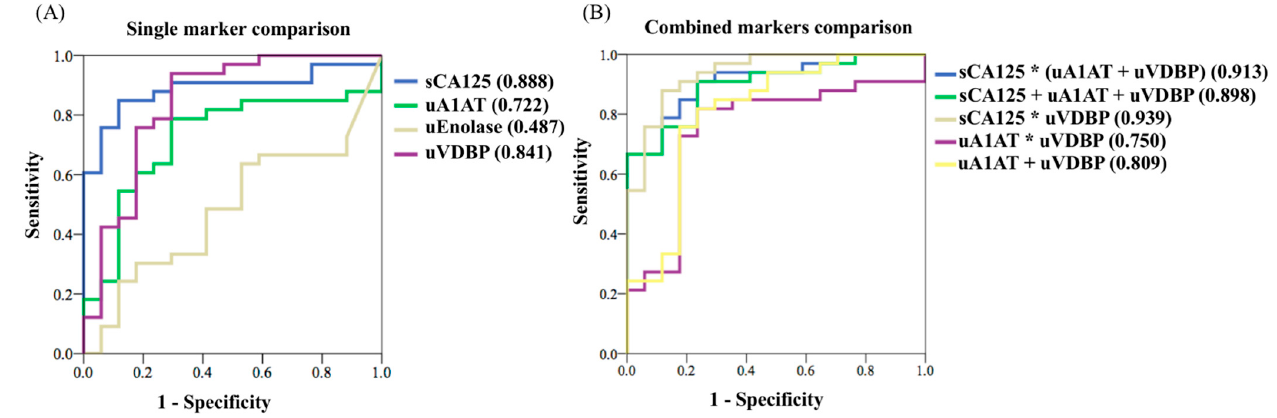
Figure 1. ( A ) The receiver operating characteristic (ROC) curve and area under curve (AUC) values of single examined biomarker. ( B ) The ROC curve and AUV values of combined examined biomarkers. A1AT = alpha 1-antitrypsin; VDBP = vitamin D-binding protein; sCA125 = serum CA125; uA1AT = urine A1AT-creatinine ratio; uVDBP = urine VDBP-creatinine ratio; * = multiply.